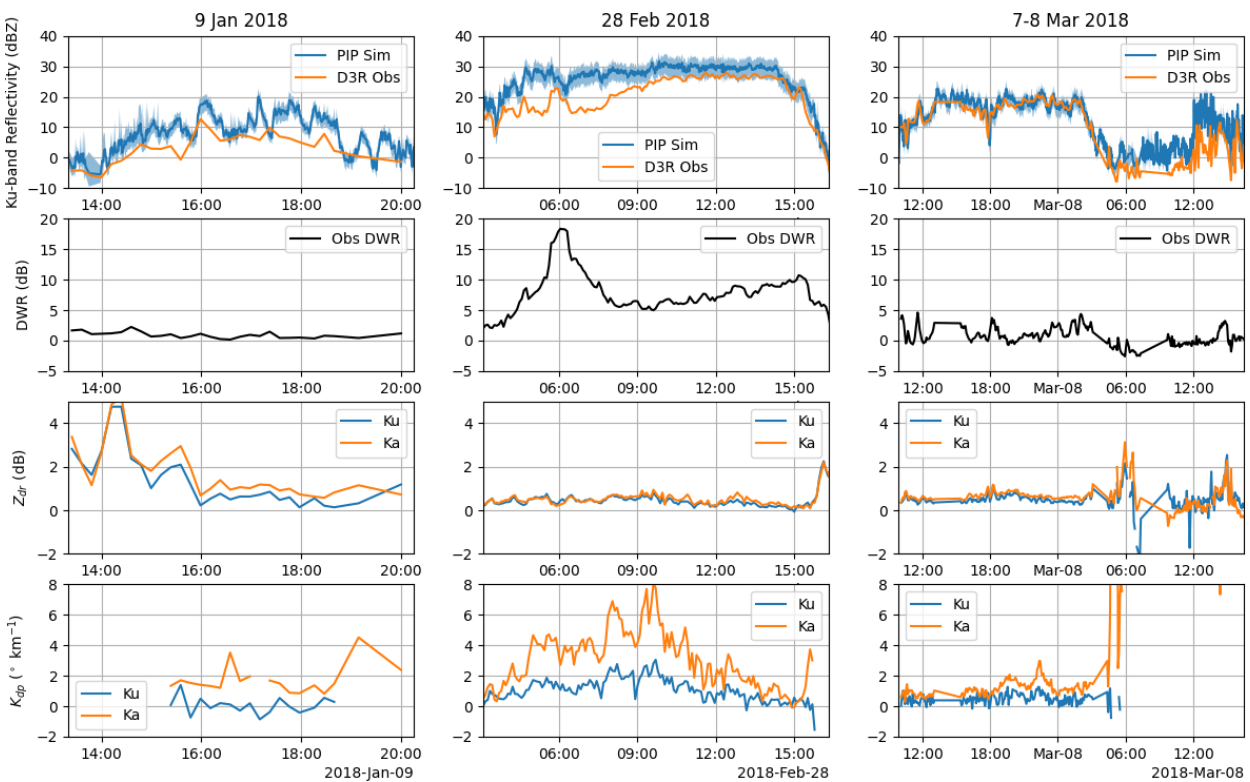
Figure 10. Time series of D3R-observed and PIP-simulated Ku-band reflectivity (top row), D3R-observed DWR (second row), D3R-observed Z dr (third row), and D3R-derived K dp for each event. The PIP simulations used Mie calculations for spherical particles with the PIP-derived effective density. Because these calculations involve a variety of assumptions to derive density from particle shape and fall speed (Tokay et al., 2022), a range between the minimum and maximum from these calculations is shaded around the mean PIP-derived